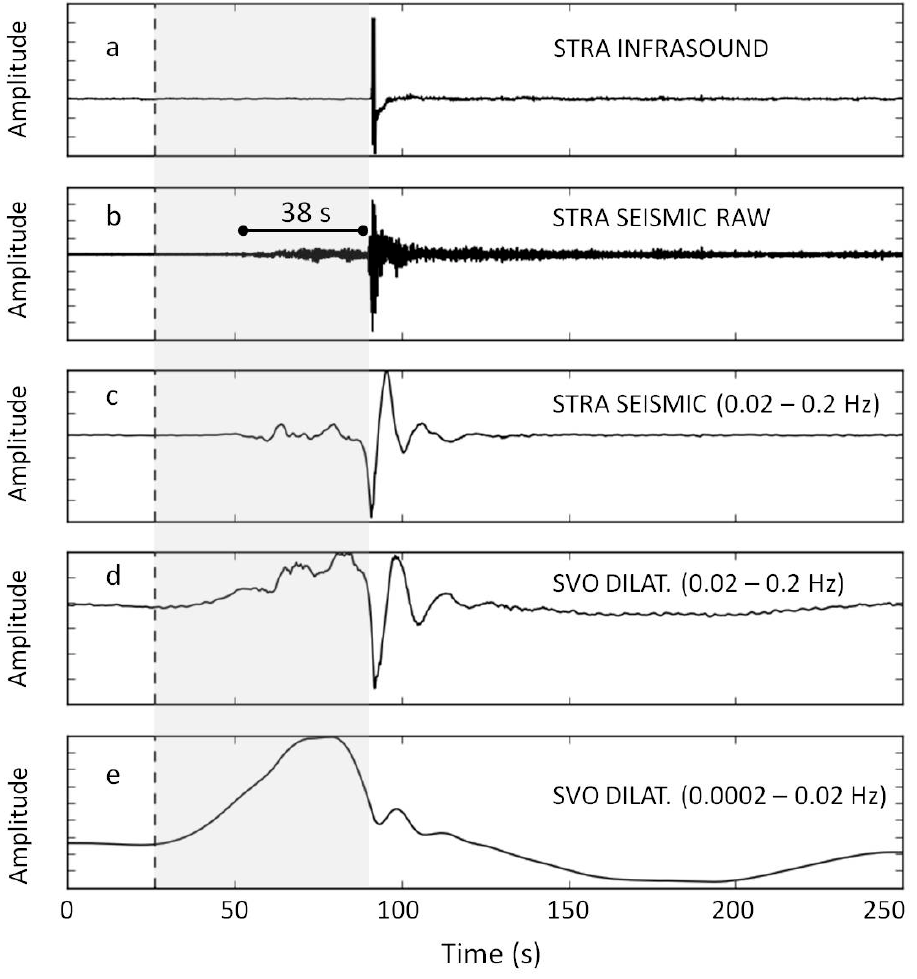
Figure 7. Recordings of the major explosion on 1 December 2017. The start time of the plot is 12:41:00.00 UTC. ( a ) Infrasonic signal (STRA, see Figure 1 for the location on the map); ( b ) raw seismic signal (STRA vertical component); ( c ) seismic signal filtered in the VLP band (0.02–0.2 Hz); ( d ) SVO strainmeter (see Figure 1 for the location on the map) filtered in the band 0.02–0.2 Hz; ( e ) SVO strainmeter (see Figure 1 for the location on the map) filtered in the 0.0002–0.02 Hz band. The grey area represents the lapse time between the initial variation detected by the strainmeter ( e ) and the start of the major explosion marked by the infrasonic signal ( a ).